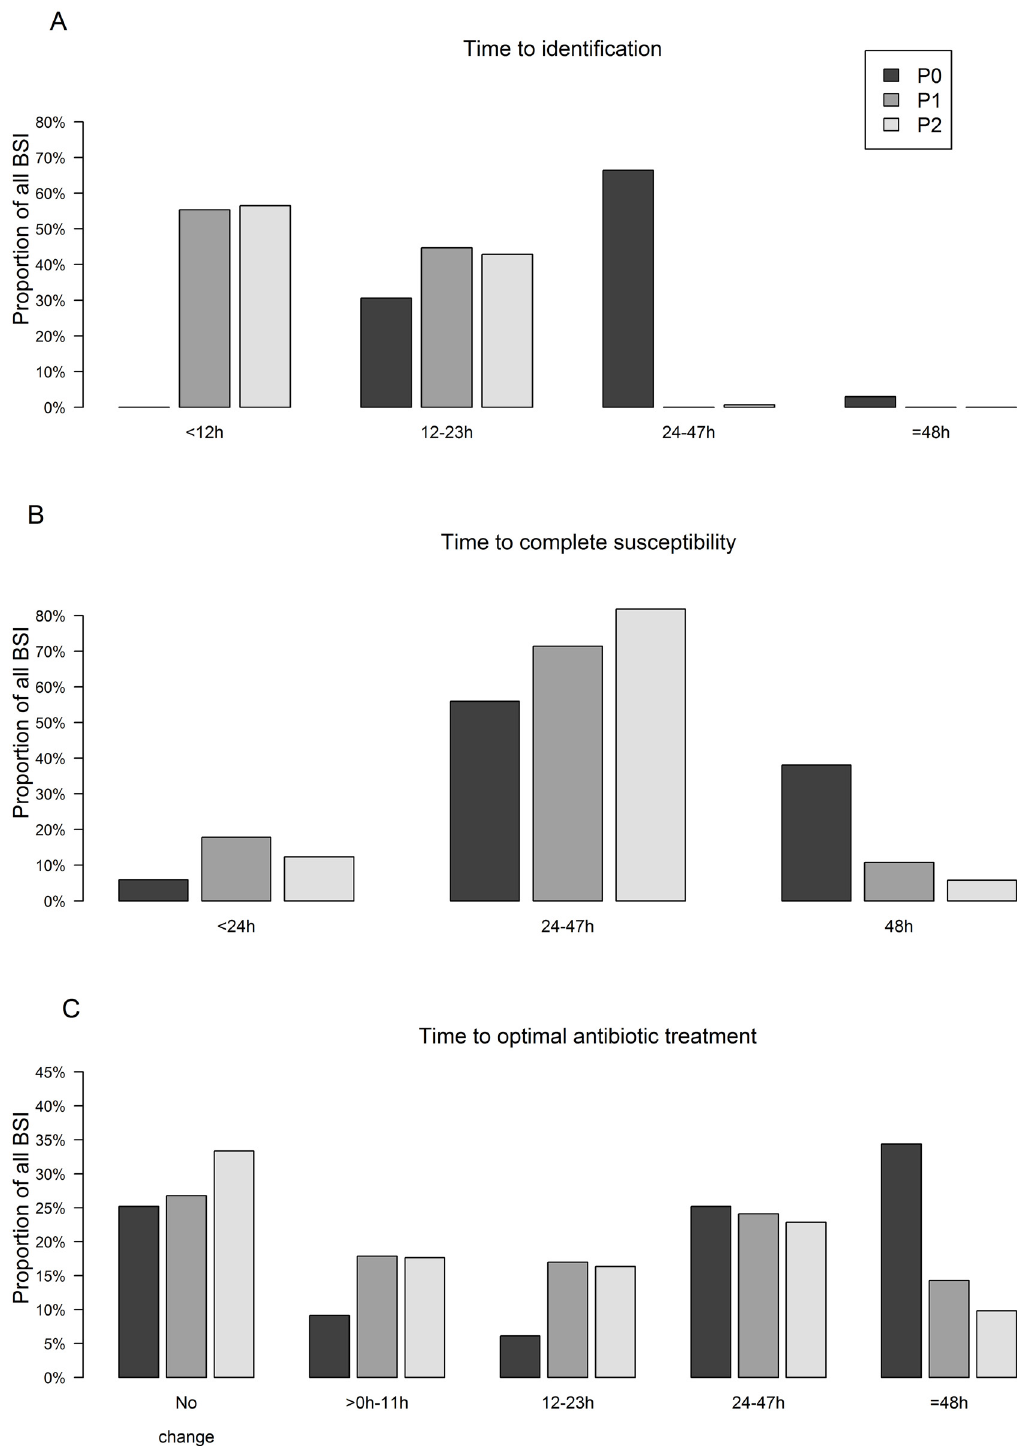
Fig 3. Distribution of the bloodstream infections over time in the three study periods according to their microbiological and clinical outcomes. (A) Distribution of the bloodstream infections identified within defined time lapses. (B) Distribution of the bloodstream infections according to the time of complete susceptibility result availability. (C) Distribution of the bloodstream infections benefitting from the optimal antimicrobial treatment within defined time lapses. The “ No change ” category defines bloodstream infections optimally treated before the detection of positive blood culture. BSI, bloodstream infection.